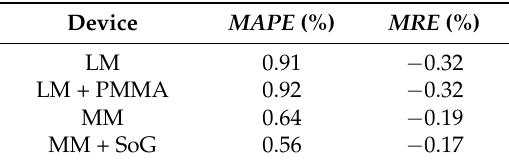
Figure 2. Actual versus simulated SF for the devices based on LM and LM + PMMA for four different days: ( a ) 21 June 2016, ( b ) 23 December 2016, ( c ) 29 June 2016 and ( d ) 18 August 2016. LM: a device based on a lattice-matched GaInP/GaInAs/Ge solar cell; LM + PMMA: a device based on a LM solar cell and a poly(methyl methacrylate) (PMMA) Fresnel lens. Table 2. Mean absolute percentage error ( MAPE ) and mean relative error ( MRE ) for the four CPV devices and days considered. CPV: concentrating photovoltaic; MM: a device based on a metamorphic (SoG) Fresnel lens; MAPE : the mean percentage absolute error; MRE : the mean relative